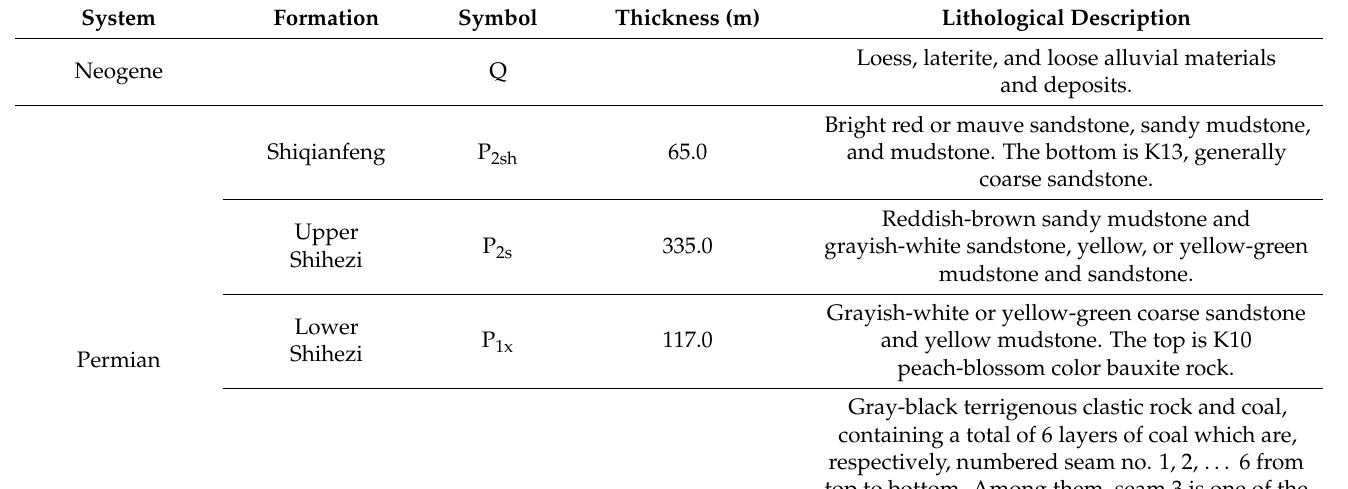
Table 1. Regional stratigraphy in Yangquan